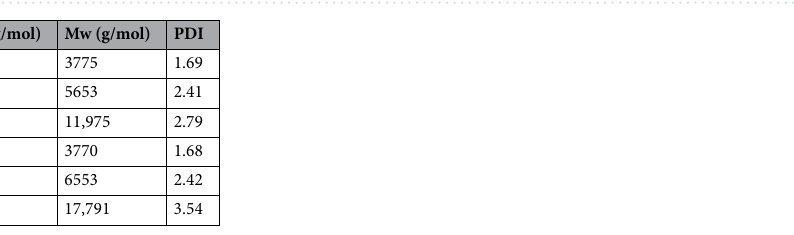
Figure 1. Molecular weight distribution curves generated for the lignin units and the fractions: ( a ) WL, SWL, and ISWL; ( b ) ML, SML, and ISML.